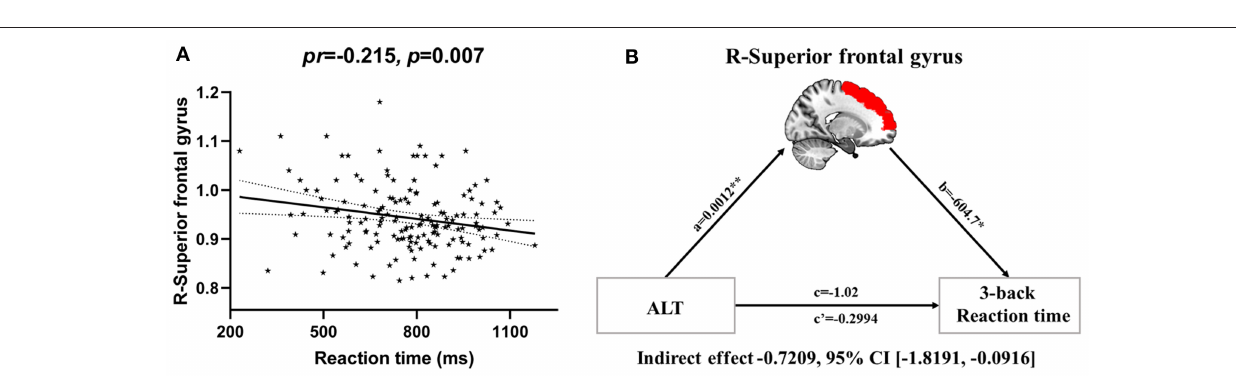
Frontiers in Neurology |